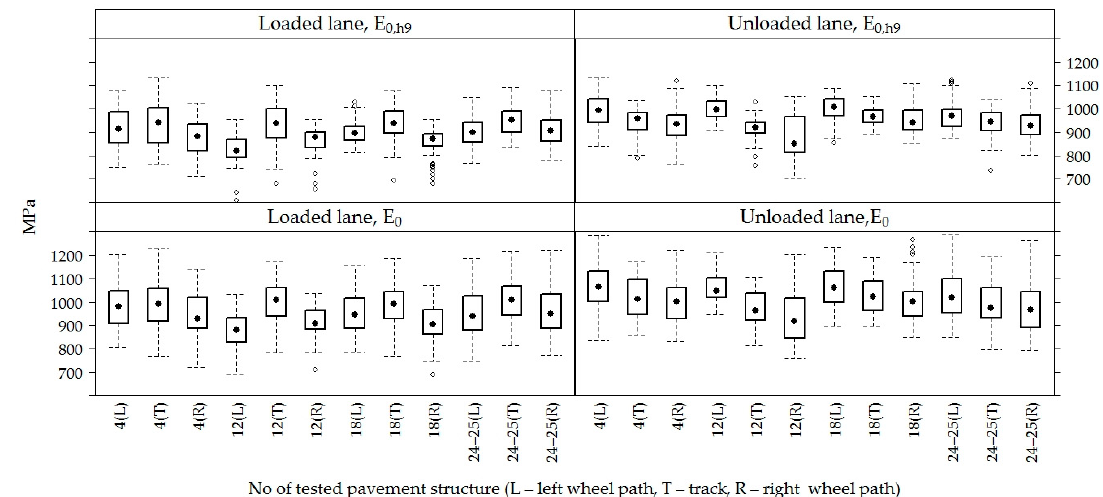
Figure 11. The box-plots of E 0 and E 0,h9 values in each loaded and unloaded lane by distinguishing the left wheel path, track and right wheel path.